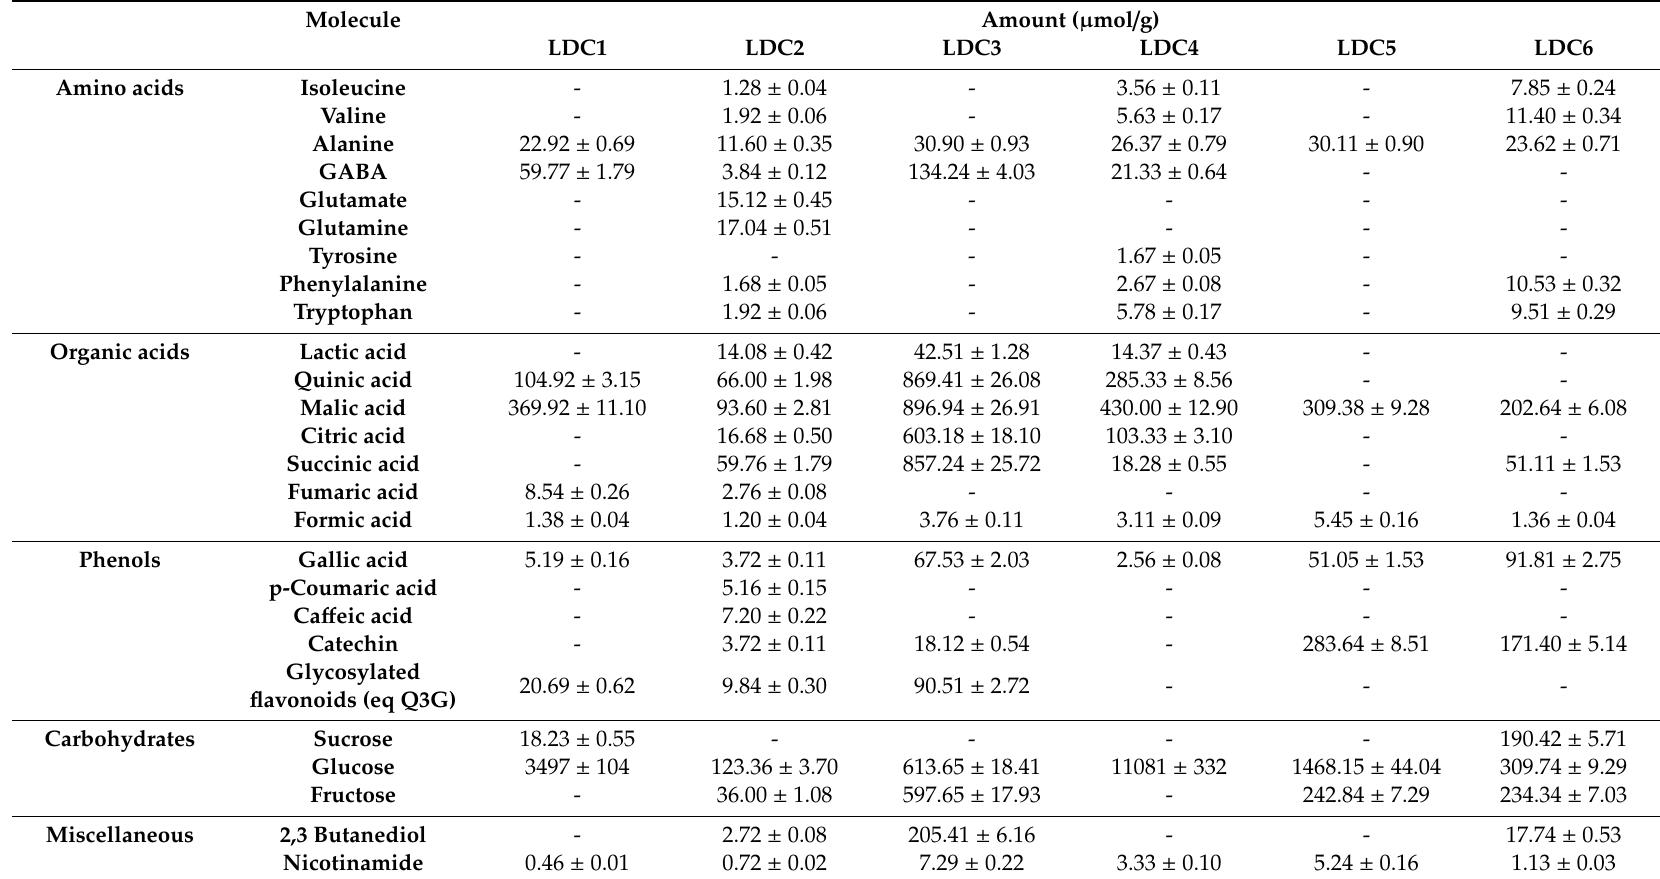
Table 1. Quantitative analysis of LDC extracts by NMR